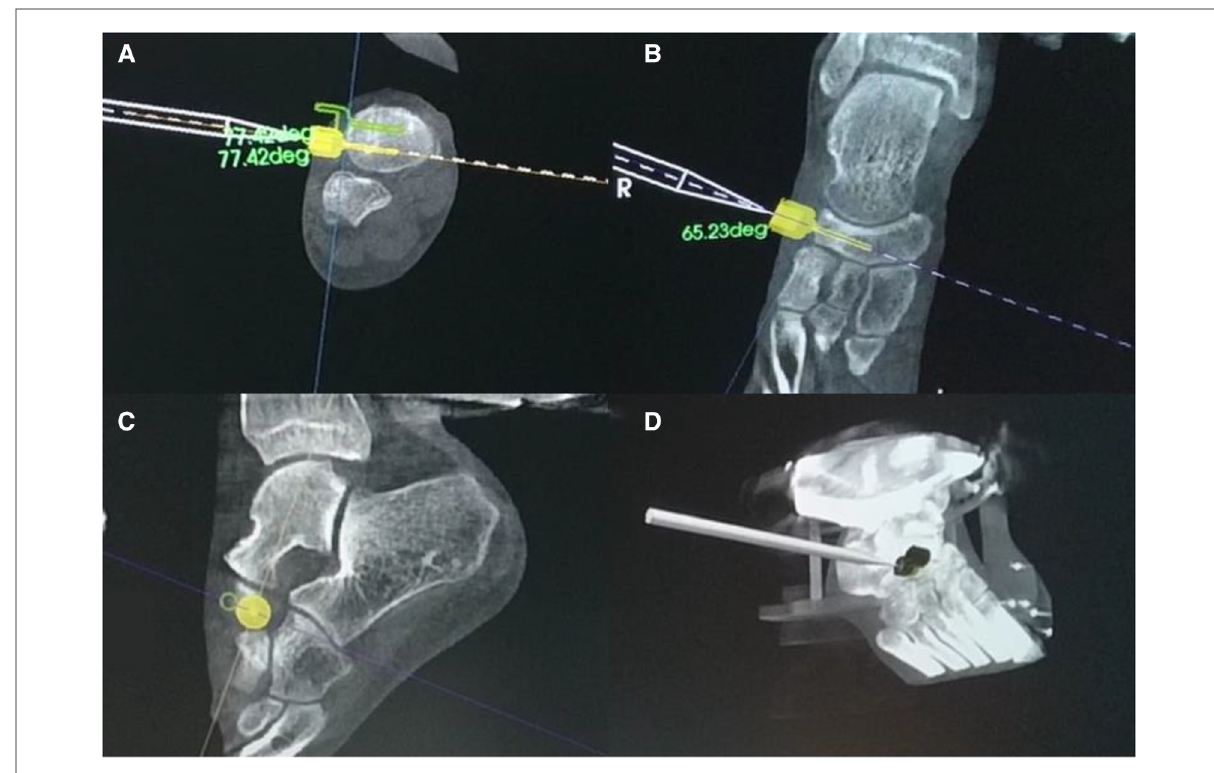
FIGURE 3 TINAVI intelligent orthopedic robot navigated during the operation and calculated the screw placement trajectory according to three-dimensional CT. ( A ) CT axial view of the right foot; ( B ) CT coronal view of the right foot; ( C ) CT sagittal view of the right foot; ( D ) 3D CT reconstruction of the right